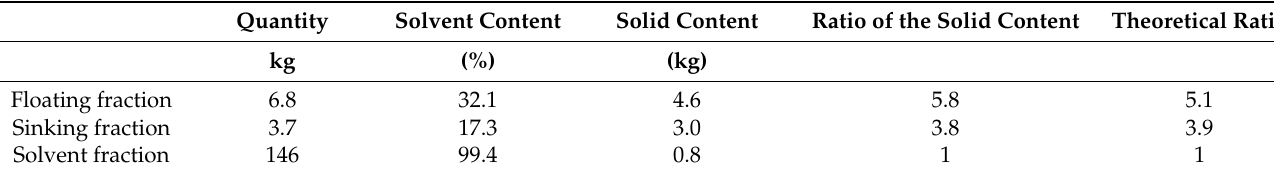
Table 4. Overview of the quantities of the floating and sinking fractions obtained after density separation and the solvent fraction containing the adhesive.